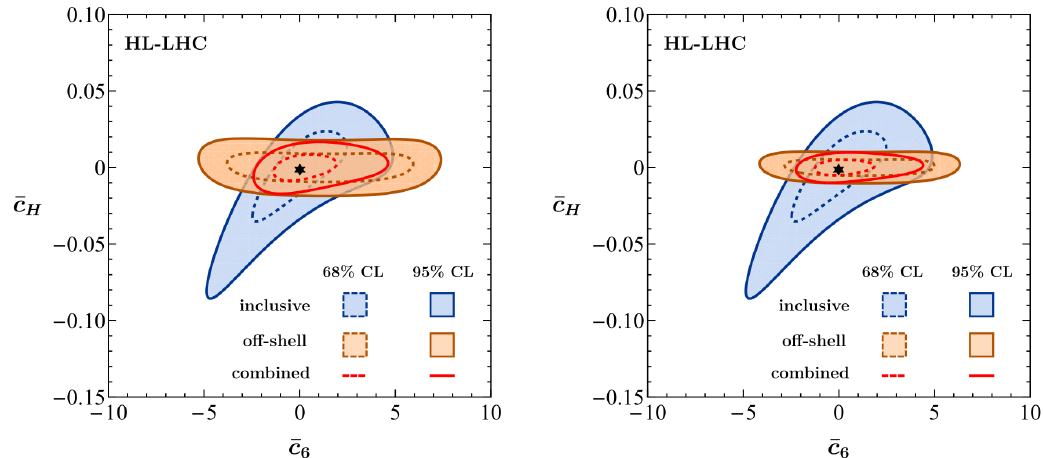
Figure 9. Projected 68% and 95% CL constraints in the ¯ c 6 – ¯ c H plane for the HL-LHC assuming √ 3 ab − 1 of data collected at s = 14 TeV . The constraints from inclusive single-Higgs probes (blue regions) are compared to the off-shell Higgs constraints (orange regions). The left (right) off-shell Higgs constraints employ a bin-independent systematic uncertainty of ∆ i = 0 . 08 ( ∆ i = 0 . 04 ) in the shape fit to the D S distribution. The combinations of all constraints are also shown as red contours. The black stars represent the SM point. For additional details see the main